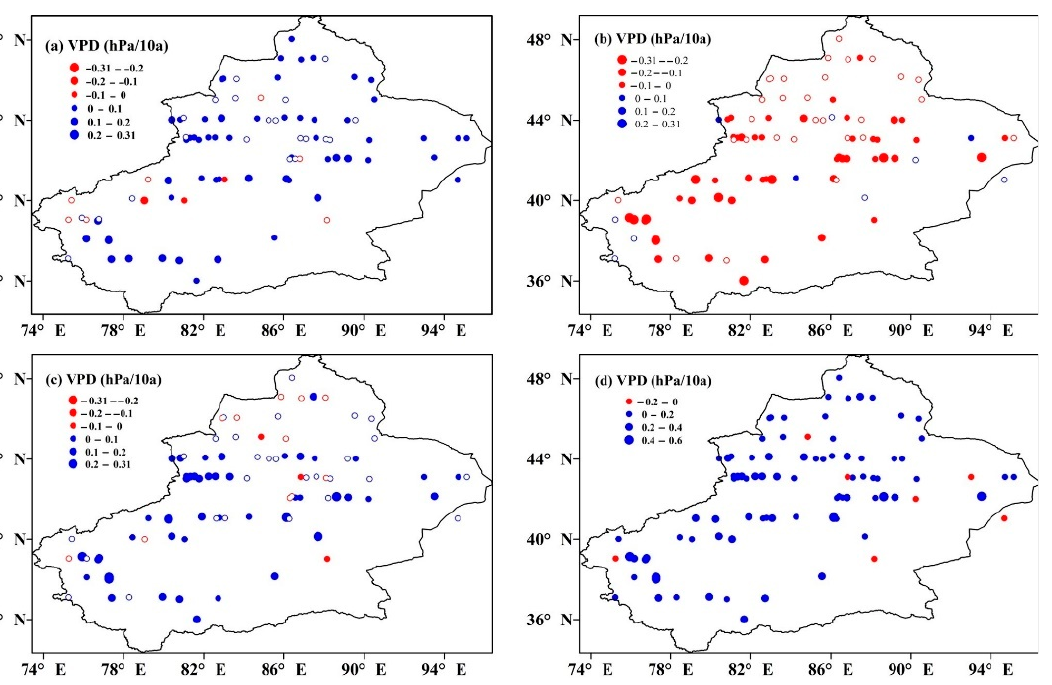
Figure 9. Change in the VPD trends over Xinjiang, China, from 1982 to 2015. ( a , b ) Time series of VPD over the GS and JJA. ( c ) Mean monthly VPD trends between the two periods of 1982–1996 and 1997–2015.